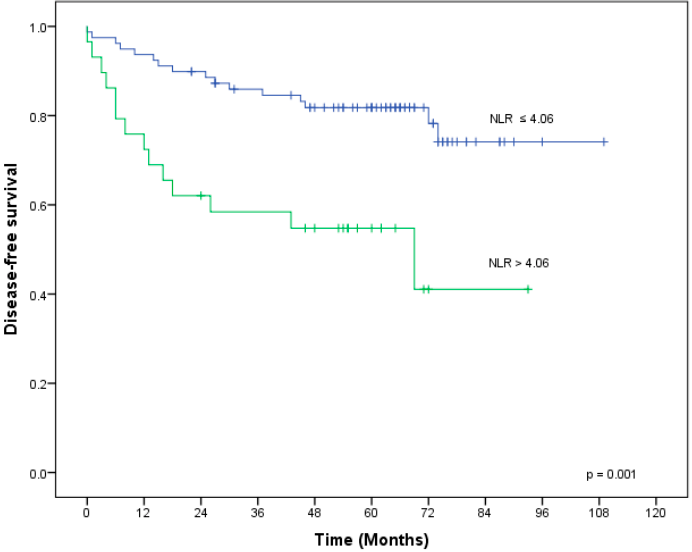
Figure 1. Disease-free survival in relation to NLR.